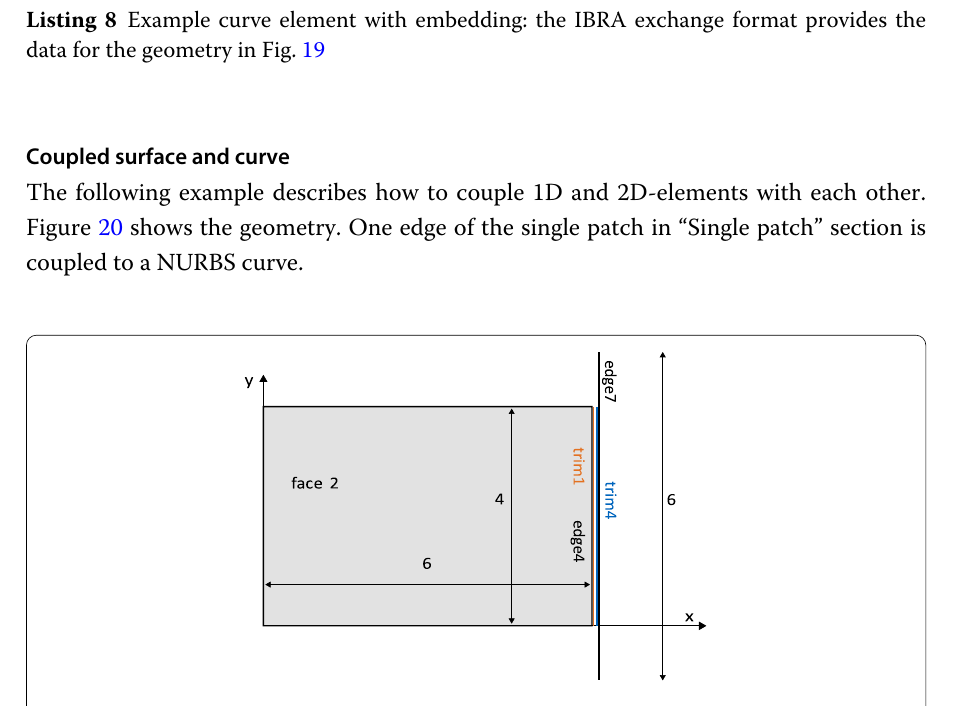
Fig. 20 Example coupled surface and curve: one edge of the surface of Fig. 17 is coupled to a adjacent